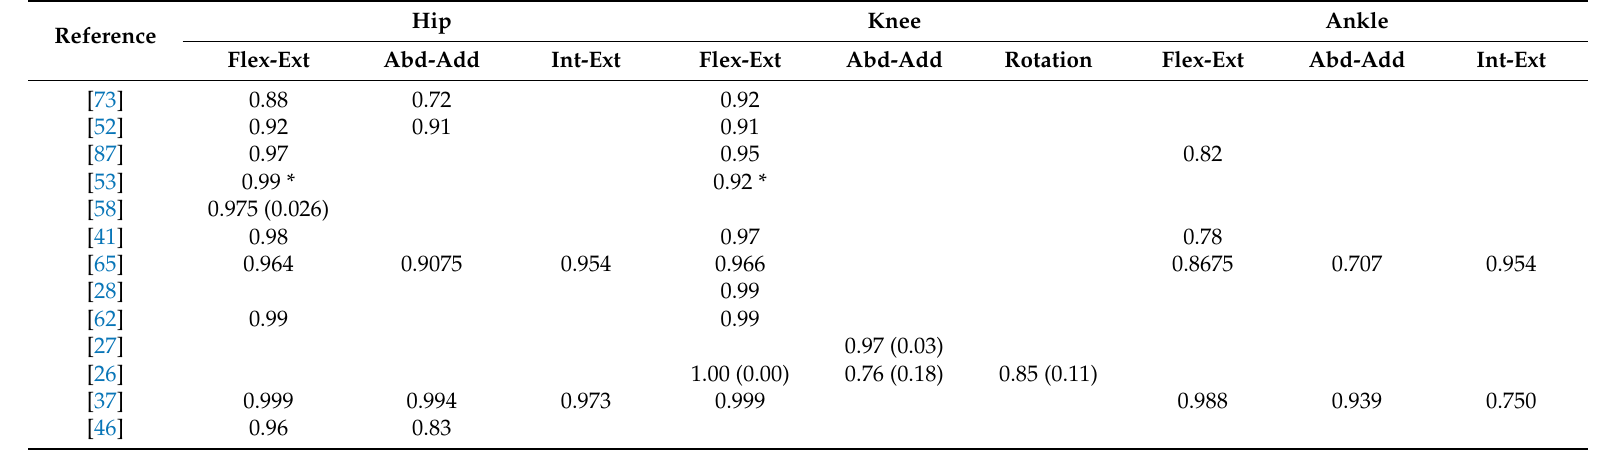
Table 6. Pearson Correlation Coe ffi cients for each study that uses it, Mean (standard error).